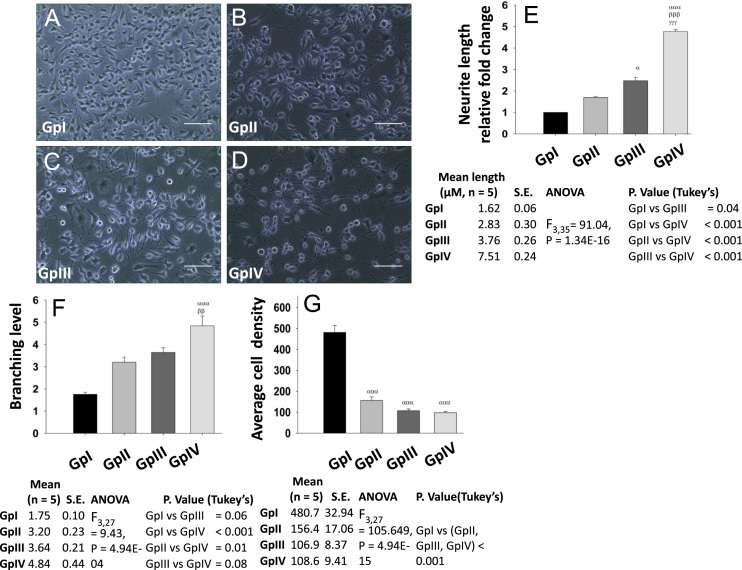
Phase contrast microscopy for morphological analysis. Neuro-2a cells were subjected to various culture conditions, namely DMEM + 10% FBS (GpI), DMEM + 10% FBS + 20 μM Retinoic acid (GpII), DMEM + 0.1% FBS (GpIII), DMEM + 0.1% FBS + 20 μM Retinoic acid (GpIV) and then photographed with Nikon-C100 at 20× magnification. Scale bar 5 μM. Data are represented as photomicrographs (A–D) and its analysis of neurite length (E), the branching level (F) and average cell density (cells/475 μm2, G) in bar graphs. Values are mean ± S.E. P ≤ 0.05 (α, β, γ), P ≤ 0.01 (αα, ββ, γγ), P ≤ 0.001 (ααα, βββ, γγγ) were considered to be statistically significant. α, Compared to GpI; β, Compared to GpII; γ, Compared to GpIII. Additionally, mean values, S.E., ANOVA, and Tukey׳s multiple comparisons statistics (post hoc) are shown in tabular form below their respective graphs.